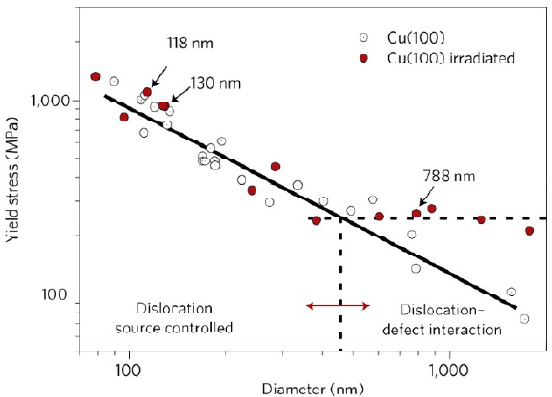
Fig. 11. Comparison of size dependent behavior of irradiated and unirradiated copper samples. While the unirradiated copper (open circles) exhibits a size dependent yield strength over the whole size range, the irradiated samples (red symbols) show this be- haviour only when the size is less than 400